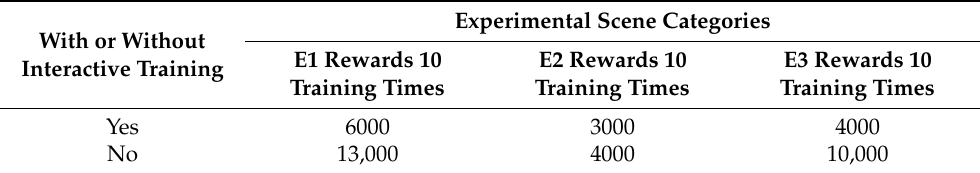
Table 5. Comparison of the training number of interactive self-learning and evolutionary. With or Without